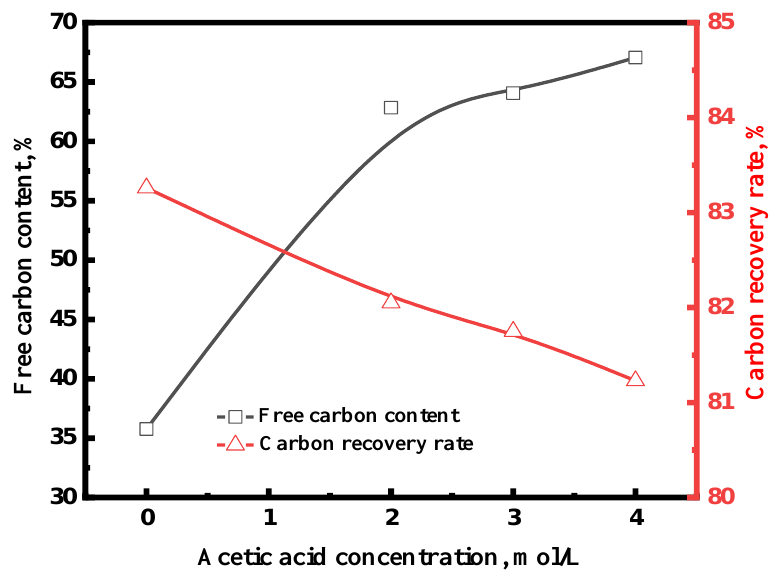
10 of 15 Figure 11. Microstructures of carburized pellet at different carburization times (iron carbide: white). 3.2. Preparation of Carbon Concentrate Effect of Acetic Acid Concentration Figure 12 shows the influence of acetic acid concentration on the free carbon content and carbon recovery rate of acid leaching concentrate. Without acid leaching, the free car- bon content and carbon recovery rate of acid leaching concentrate were 35.77% and 83.26%, respectively. When the tailing was leached in the acetic acid, the free carbon con- tent of acid leaching concentrate significantly increased, whereas the carbon recovery rate